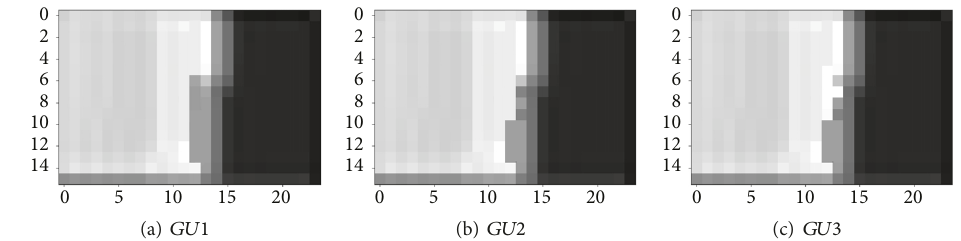
Figure 10: The 𝐺𝑈 representation in different trajectory 2 of the line tracing robot.